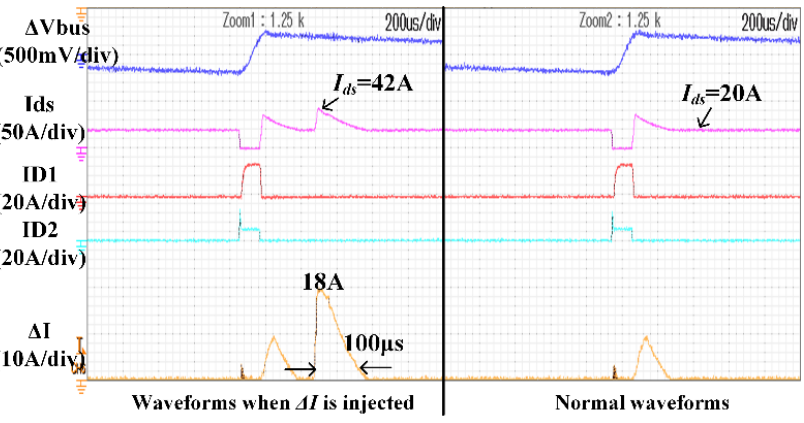
Figure 19. ∆ I is injected during the on-time of Figure 19. Δ I is injected during the on ‐ time of MOSFET.